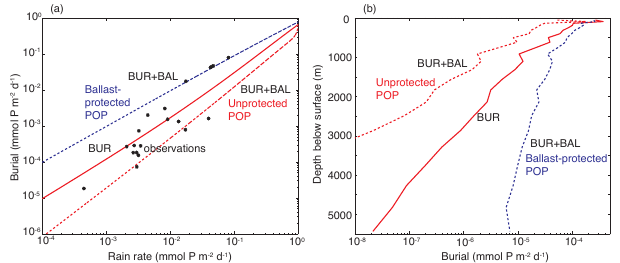
Figure 9. (a) POP burial rate vs. the rain rate (rate of delivery of POP to sediments) for the BUR and BUR+BAL models (averaged over the four different model configurations). For the BUR+BAL model, the relationship between burial and rain rate differs substan- tially for ballast-protected (blue dashed curve) and unprotected POP (red dashed curve). Observations (marked with a *) are taken from Table 4 of Kriest and Oschlies (2013) using C:P ratios from Fig. 3 of Wallman (2010). (b) POP burial rate as a function of depth in the BUR and BUR+BAL models (averaged over the four different model